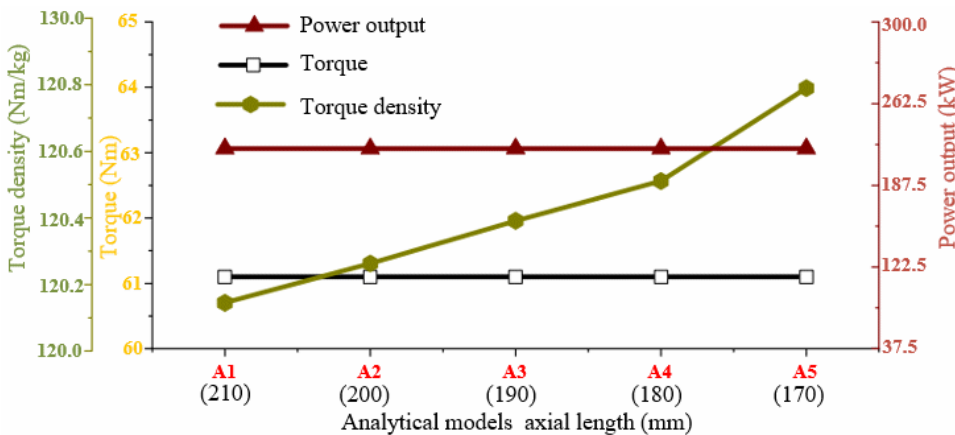
Figure 5. Correlation between models axial length with torque, torque density, and power output under rated conditions.